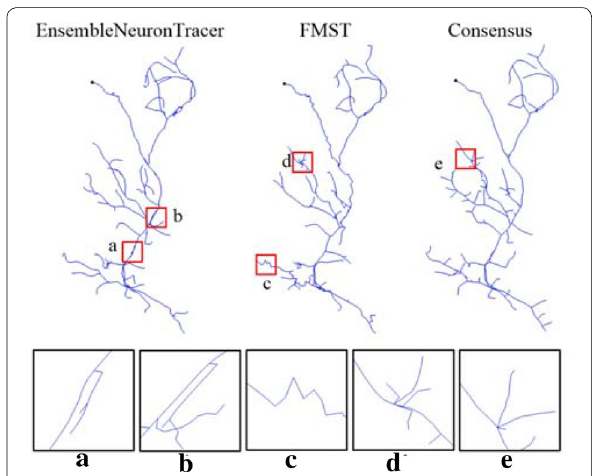
Fig. 1 Inaccurate substructures on three reconstructions of a neuron. Reconstructions generated by Ensemble Neuron Tracer, FMST and a consensus strategy have some inaccurate substructures marked by a – e , which have too many branches or